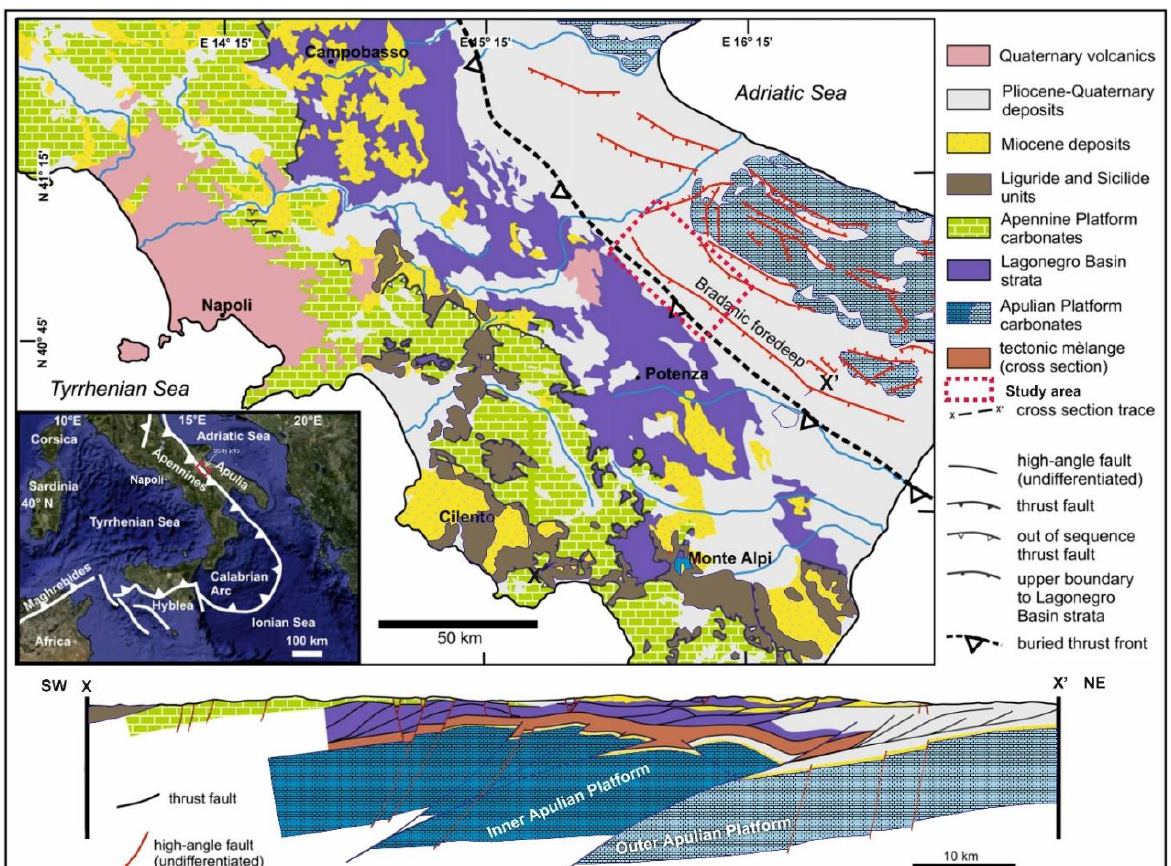
Figure 1. Simplified geological map of southern Apennines, Italy, and NE–SW geological cross-section modified from [50]. The sketch map in the inset shows the structural setting of southern Italy, in which the red box represents the location of the study area (also reported in the main figure).